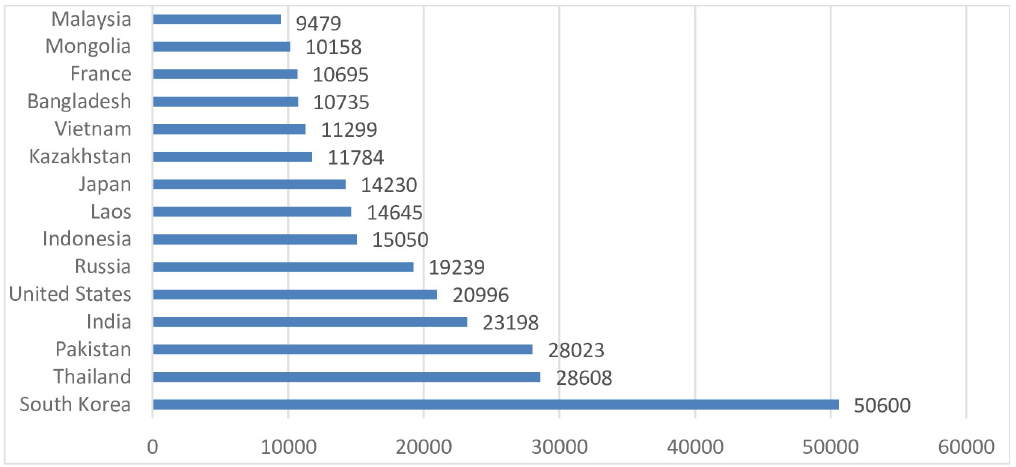
Fig 2. International students by country of origin in China, 2016–17.